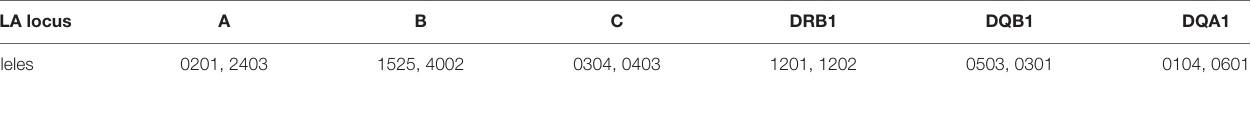
TABLE 2 | Identified alleles of human leukocyte antigen (HLA) class I and II at the selected loci. HLA locus A B C